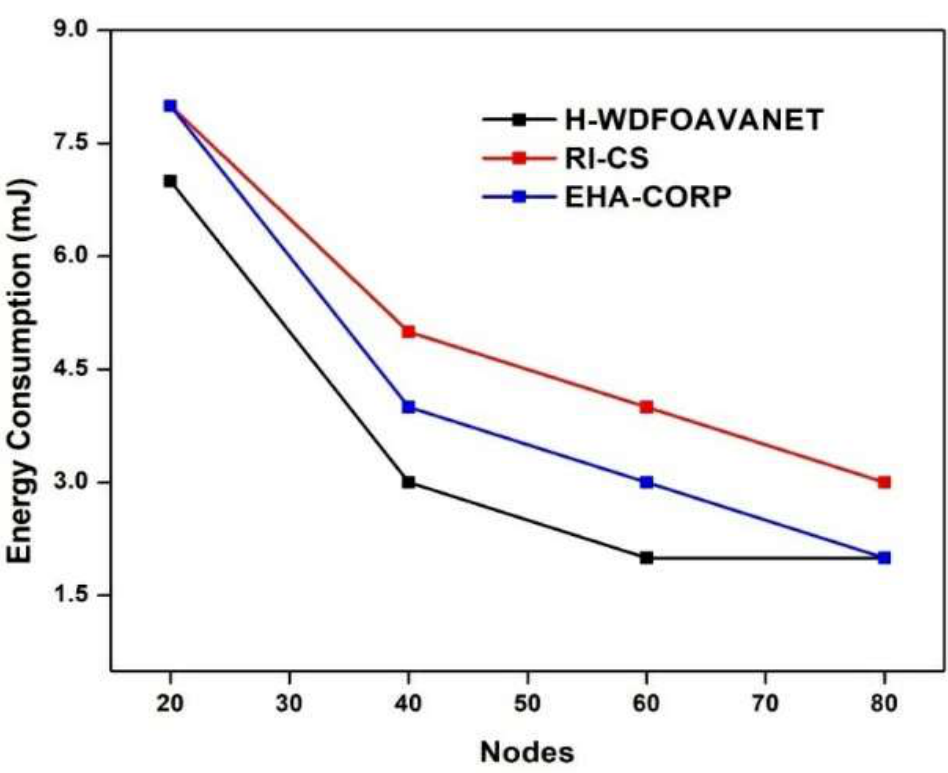
Figure 17. Plots of nodes vs. energy consumption in the suggested approach and existing approaches.